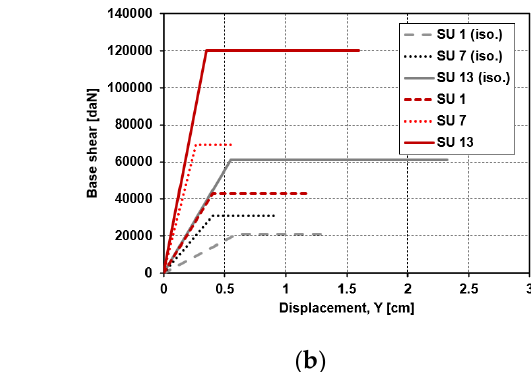
Figure 9. Numerical model of the reference case study SUs: ( a ) head SU, ( b ) intermediate SU confined on 3 sides, and ( c ) intermediate SU confined on 2 sides.